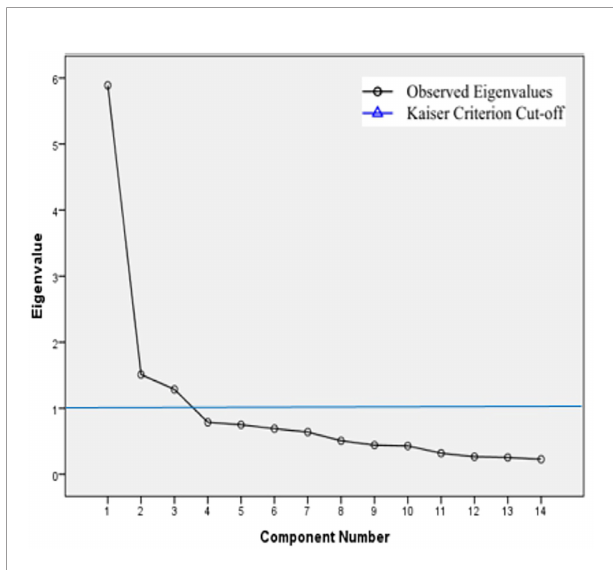
FIGURE 2 | Scree plot with the Kaiser